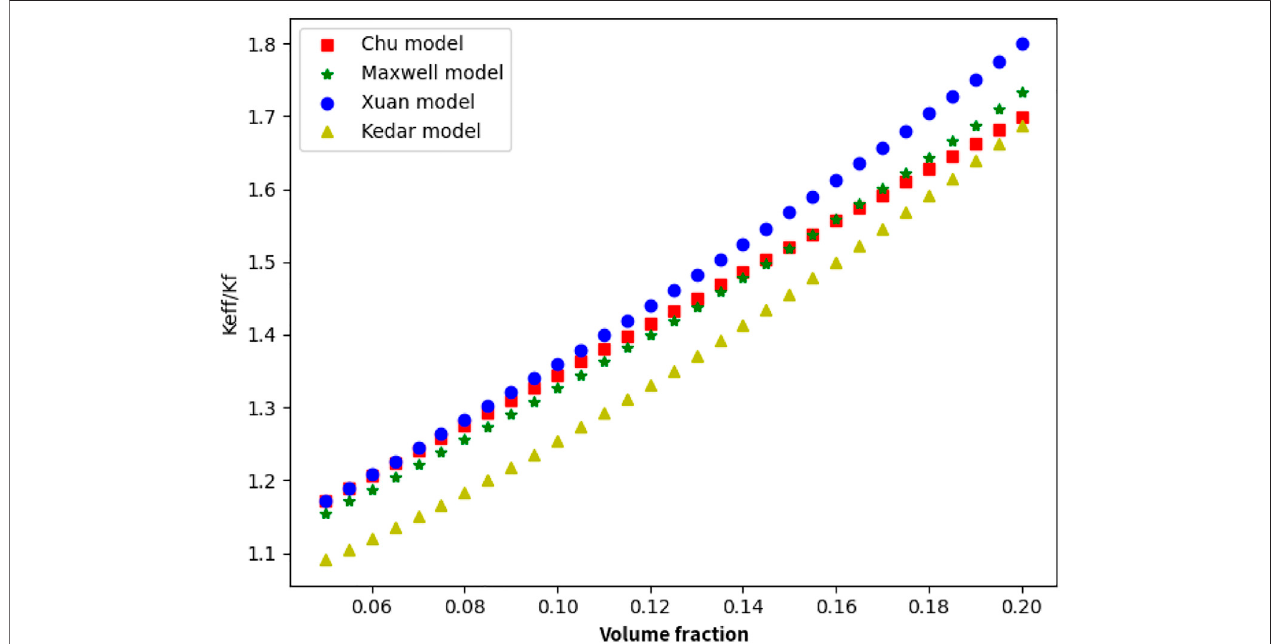
FIGURE 3 | Variation in the thermal conductivity with nanoparticle concentration ( T (cid:2) 600 K, r (cid:2) 20 nm).